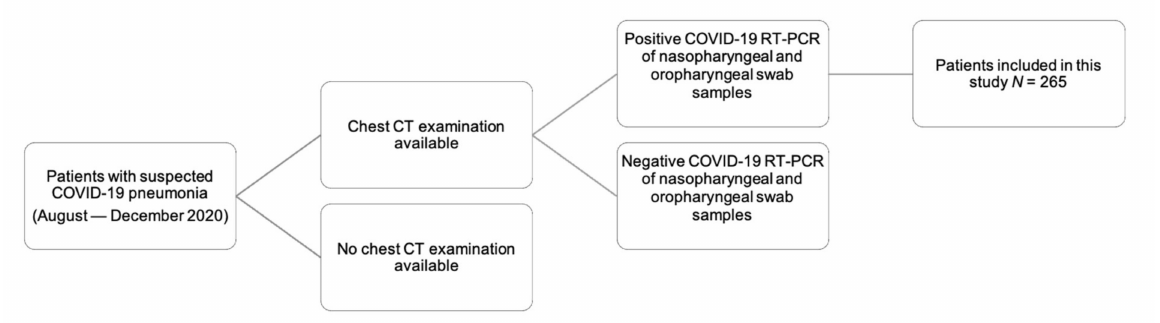
Figure 1. Patient population. We retrospectively enrolled 265 patients admitted to our central European level-1 univer- sity center. All patients included underwent a chest CT examination and tested positive for SARS-CoV-2 (RT-PCR of nasopharyngeal and oropharyngeal swab samples); patients with a negative swab test were